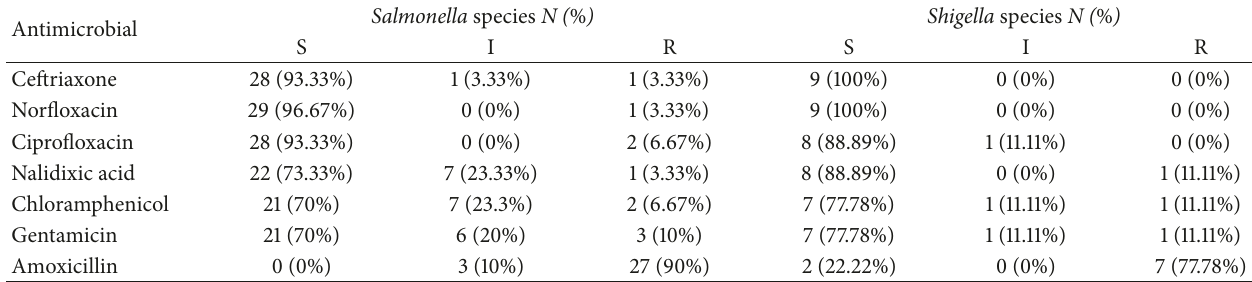
Table 2: Antibiotics susceptibility pattern of Salmonella and Shigella species from diarrheal patients attending Nekemte Referral Hospital, October 2015 to February 2016. Antimicrobial